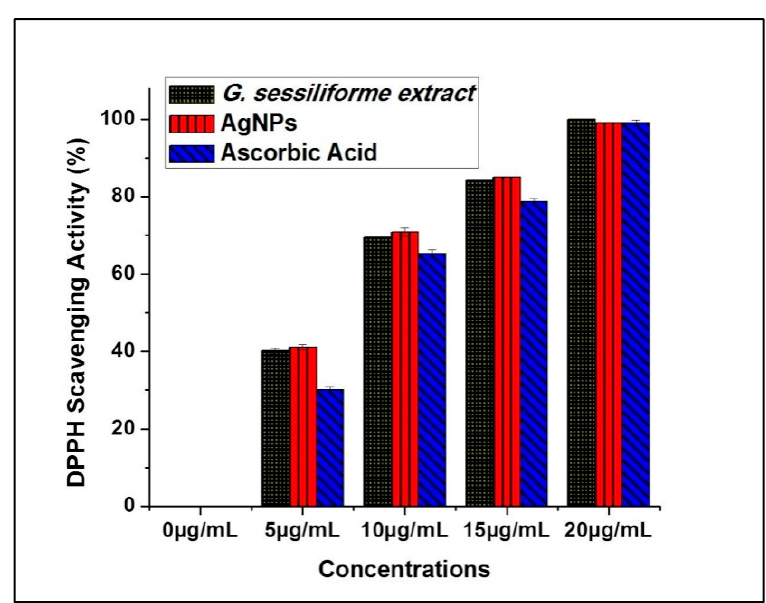
Figure 7. Antioxidant potentials of AgNPs and ascorbic acid (DPPH radical scavenging).